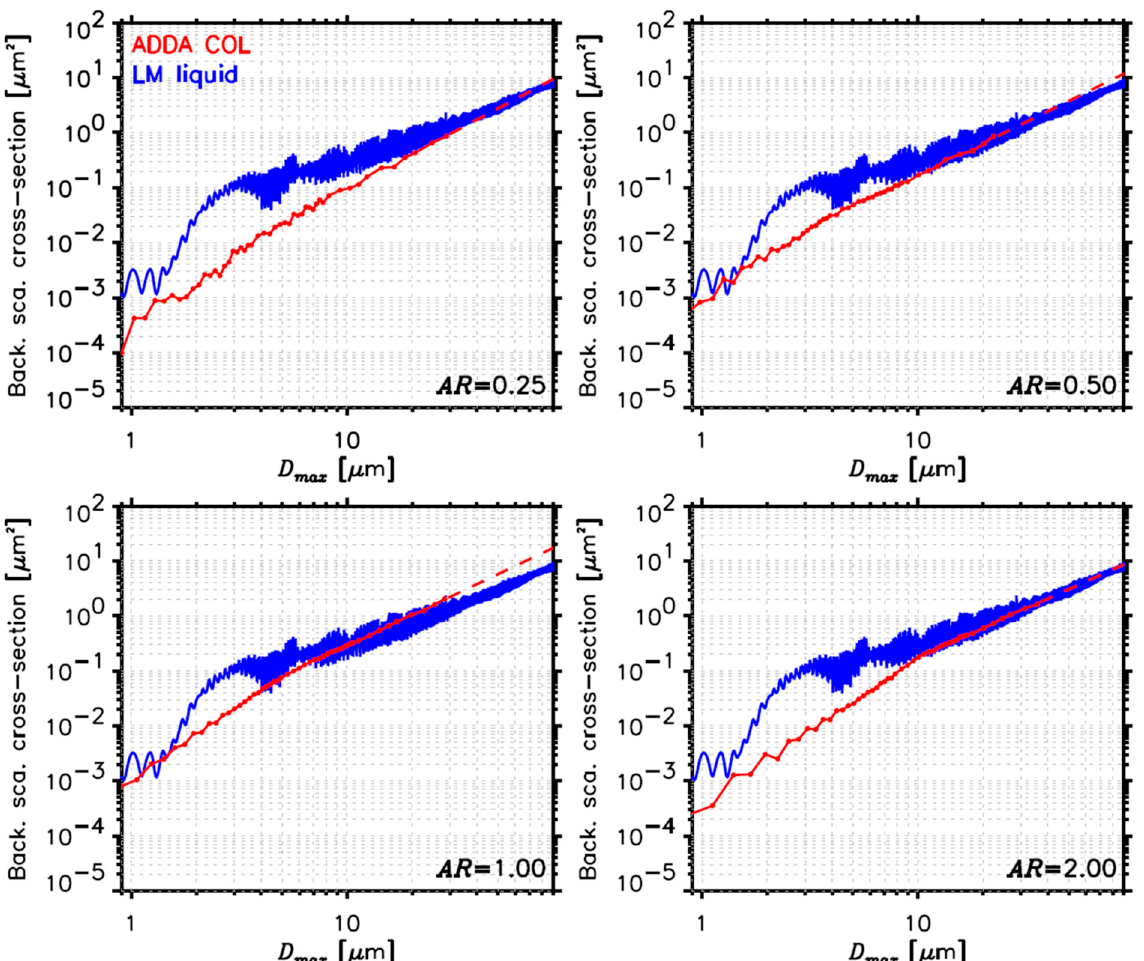
Figure 5. The same as Figure 4, except for backward (168°–176°) scattering cross-sections.